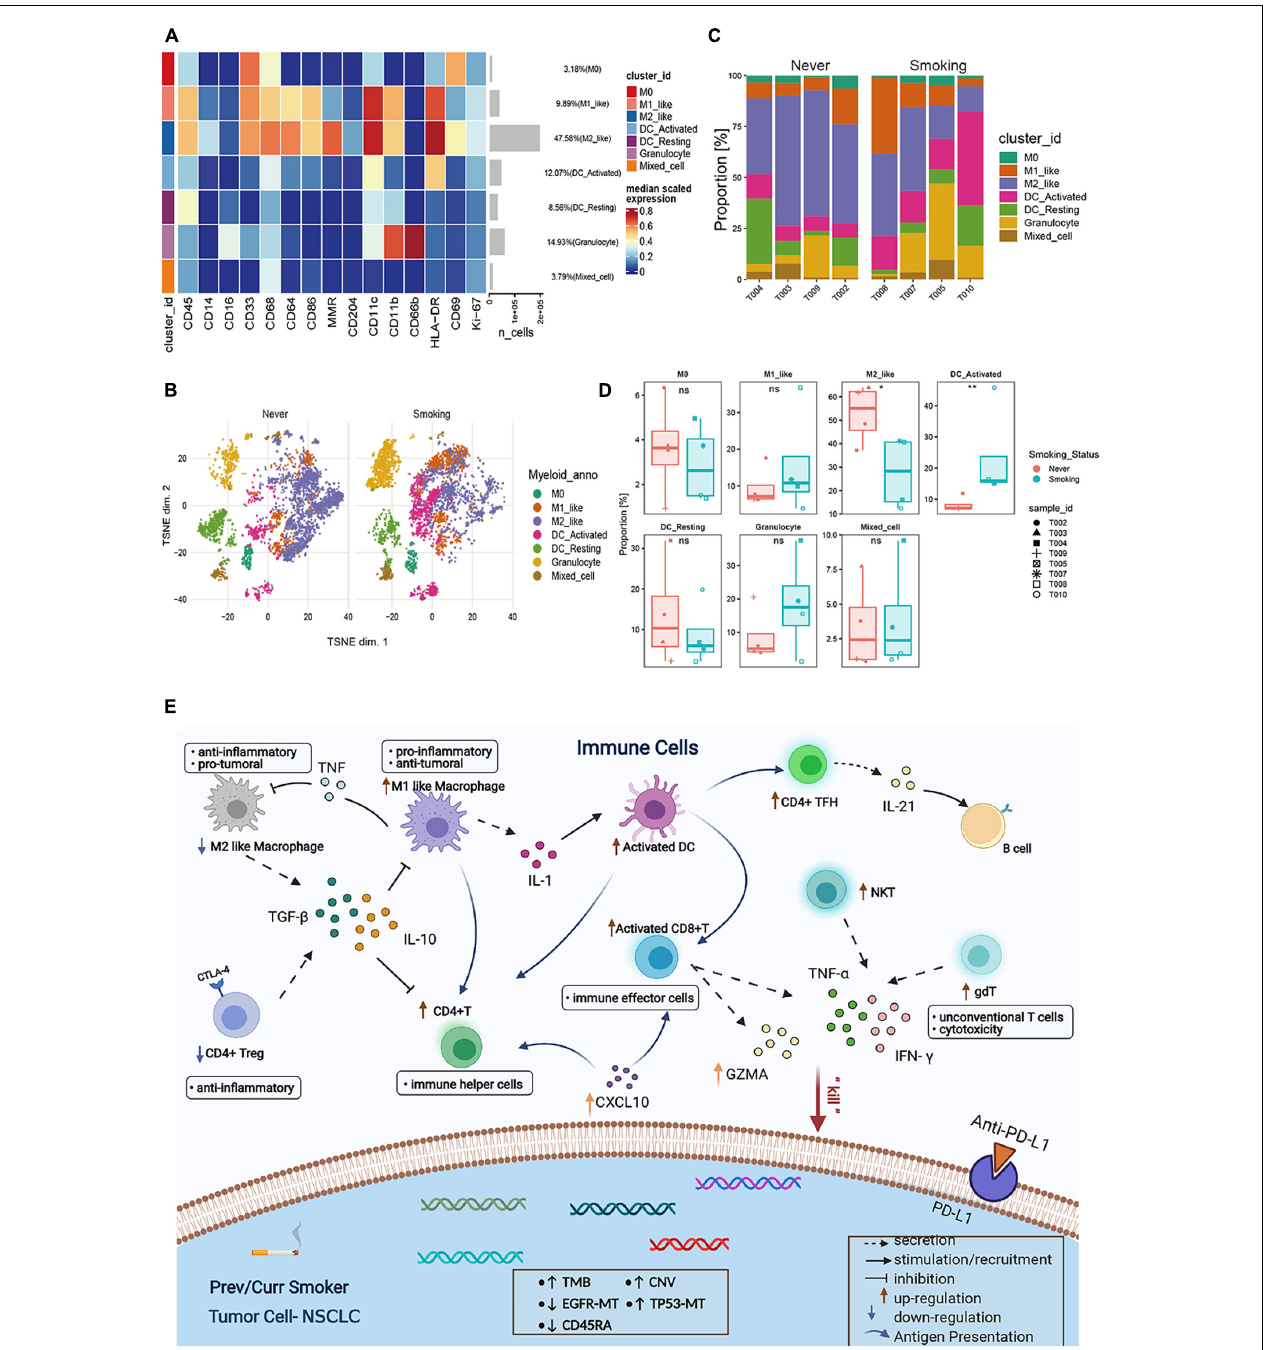
FIGURE 8 | Features of myeloid cells in NSCLC with different smoking status. (A) Heatmap of the median marker intensities of the multiple lineage markers in the 7 myeloid cell populations obtained by manual merging of the 30 metaclusters generated by FlowSOM. The heat represents the median of arcsinh and 0–1 transformed marker expression calculated over cells from all the samples. (B) t-SNE plot showing the overall distribution of different myeloid cell clusters between previous/current smokers and non-smokers. (C) Bar plot showing the relative abundance of different myeloid cell types in each sample, faceted by smoking status. (D) Box plot comparing the relative abundance of each myeloid cell cluster between different smoking status groups. Box plot center and box correspond to median and IQR, respectively. Different shapes were used to represent each patient. * p < 0.05; ** p < 0.01; *** p < 0.001; **** p < 0.0001; ns, not significant. (E) Possible mechanism for the improved prognosis after immunotherapy of smoking patients in NSCLC. Overview of the key immune cell population changes in previous or current smokers compared with non-smokers. Different immune cell types and their potential connections through cytokines, chemokines, or receptor–ligand interactions are shown in this picture. In addition, the genomic changes were also plotted inside the tumor cell. TMB, tumor mutational burden; CNV, copy number variant; MT, mutation type. Figure created with BioRender.com.